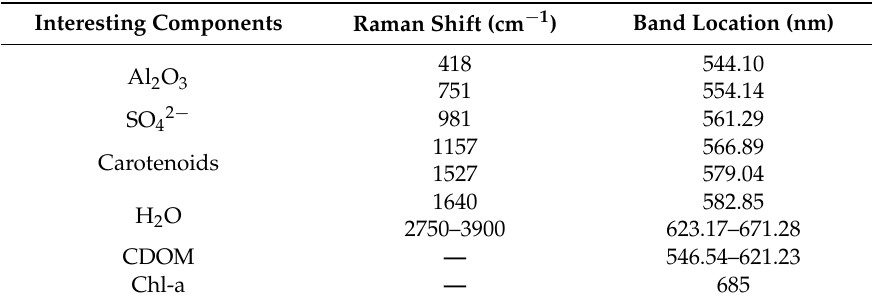
Figure 3. Typical spectrum acquired with and without correction by a fluorescence-Raman spectral system. The green line represents original data, obtained at 9:05 p.m. on 22 October, 2014. The violet line indicates the correction spectrum, and the blue line shows 12 times magnification of the correction spectrum within a range of 546.54–621.23 nm. Table 1. Raman shifts and band location of the interesting components ( λ ex = 532 nm).